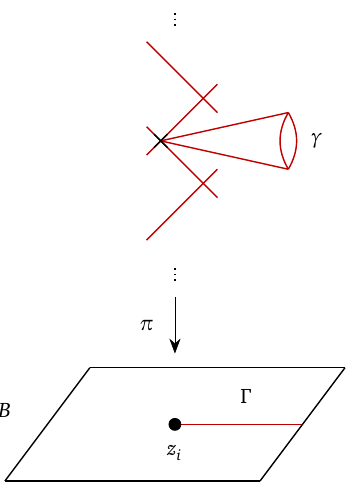
( γ ) ∈ h ( 2 ) . The thimble projects i ∈ ∆ ) as standard in . We depict the fiber π − 1 ( z i i i